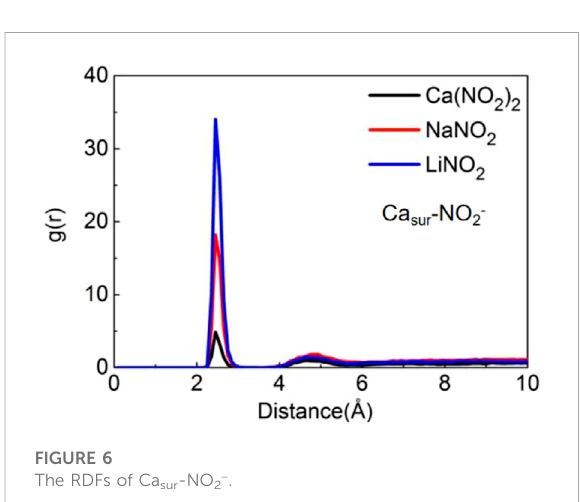
FIGURE 6 The RDFs of Ca sur -NO 2 −